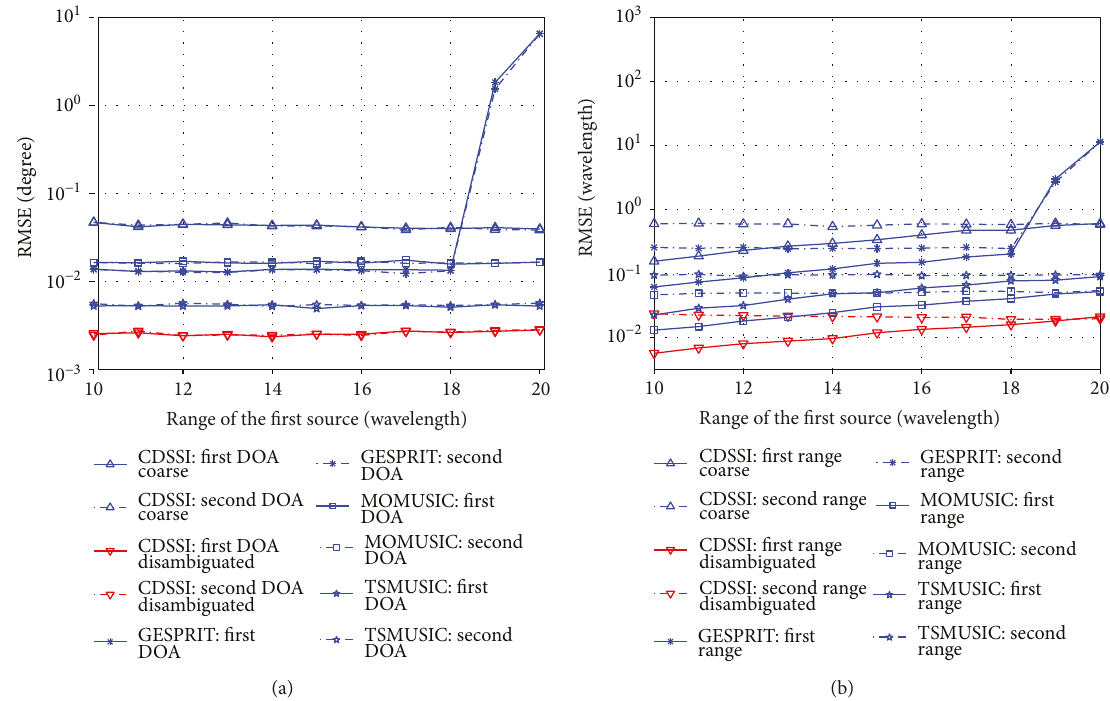
Figure 12: RMSEs of DOA and range estimates versus range gap of two NF